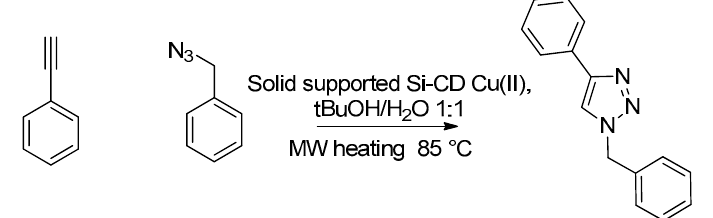
Scheme 2. Model reaction for the copper alkyne-azide cycloaddition (CuAAC) test of Si-NH-CD-Cu and Si-DETA-CD-Cu. and Si-DETA-CD-Cu. Table 2. Panel test of the CuAAC reaction.